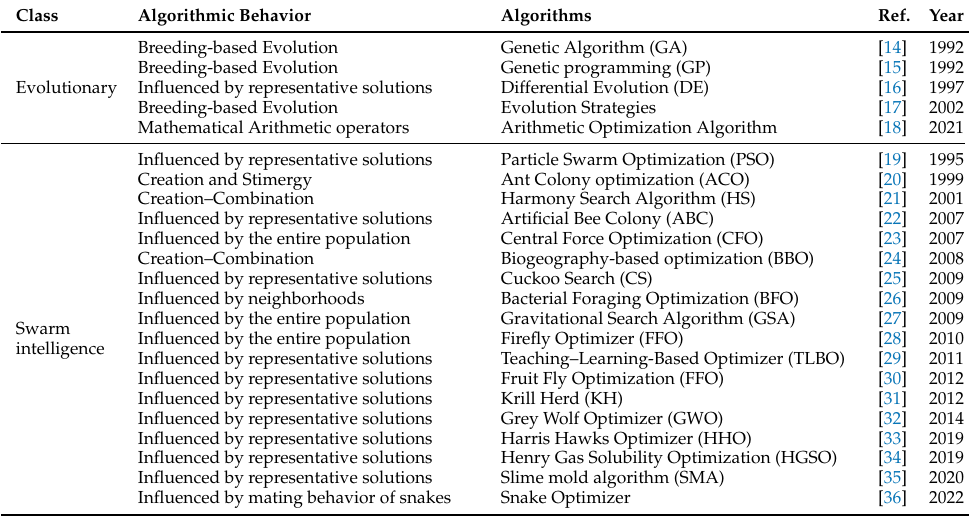
Table 1. A list of some optimization algorithms based on their